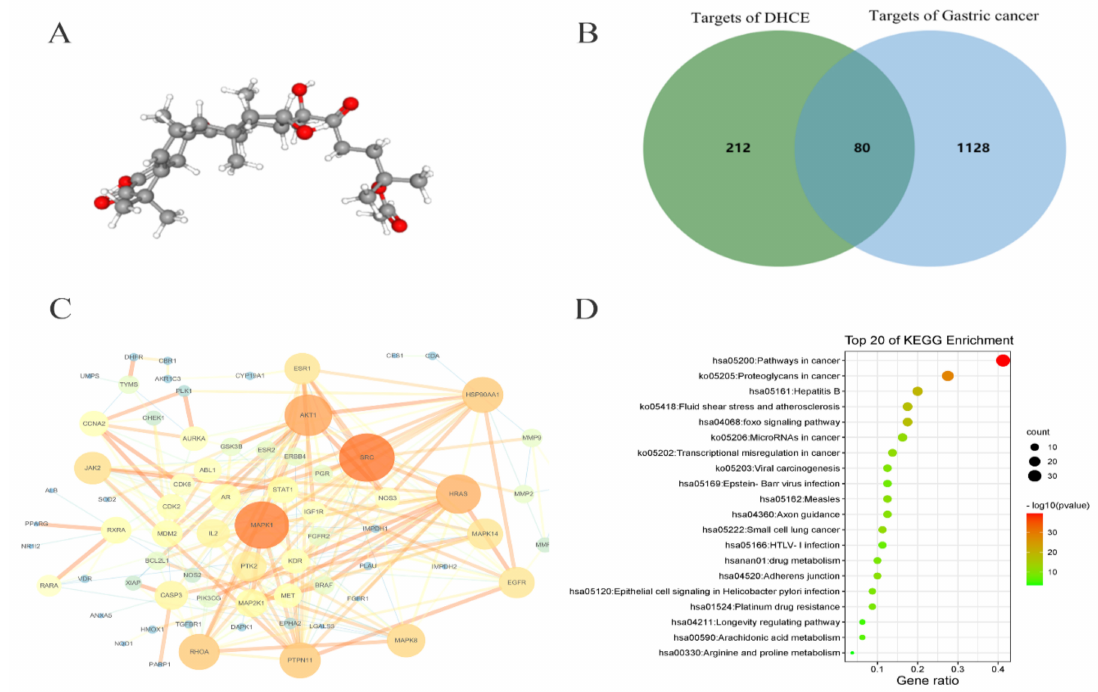
Figure 6. Targets and pathways enrichment analyses. ( A ) The 3D conformer of DHCE. ( B ) Venn diagram of 292 DHCE targets (left) and 1208 gastric cancer targets (right). Eighty common targets (middle) between DHCE and gastric cancer were identified as candidate targets for DHCE in the treatment of gastric cancer. ( C ) The PPI network of the 80 candidate targets. ( D ) KEGG pathway enrichment analysis of the 80 candidate targets. The size of dots indicates the number of genes in the KEGG